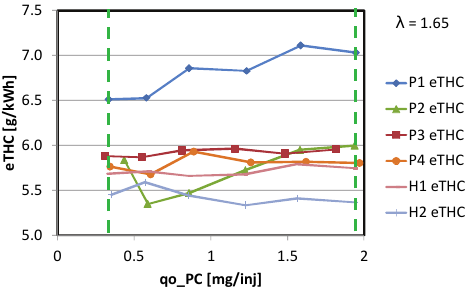
Fig. 9. Determination of the interpolated values of emission intensity (e.g. for THC)